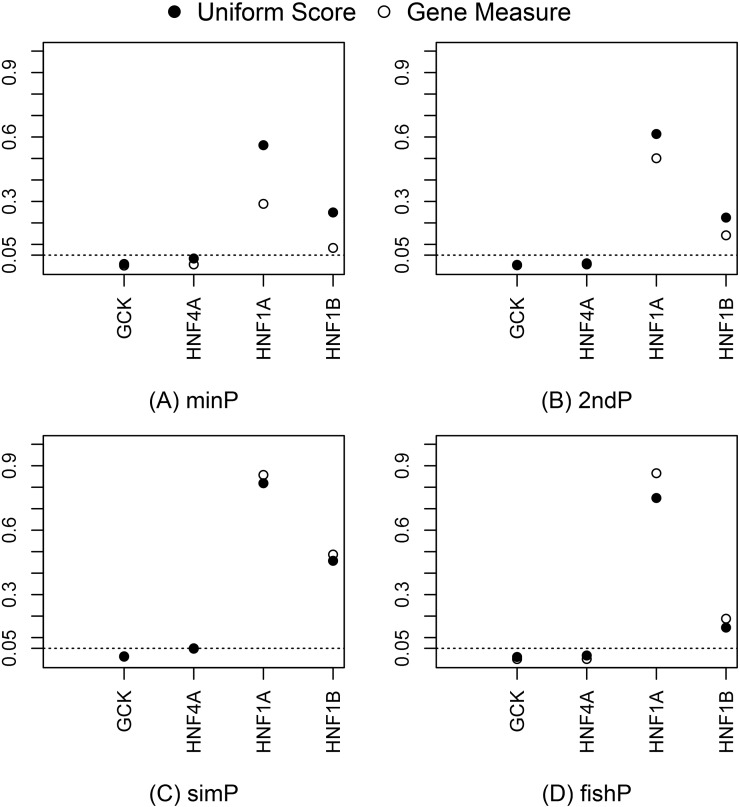
Gene measures and U-scores for GCK, HNF4A, HNF1A, and HNF1B using the type 2 diabetes genome-wide association study. The gene measure values and transformed U-scores for all four genes using (A) minP, (B) 2ndP, (C) simP, and (D) fishP.